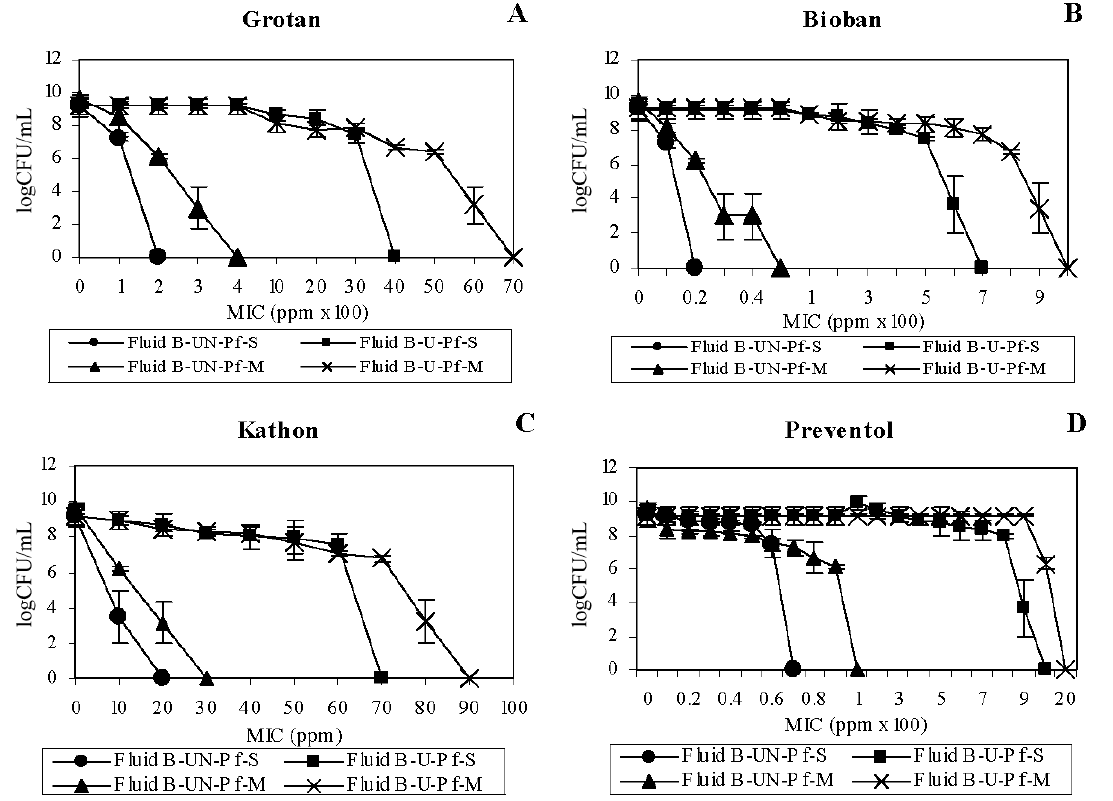
Figure 6. Effect of fluid use on biocidal efficacy toward P. fluorescens . Pristine (unused) and used Fluid B matrices were used to compare the biocidal efficacy of the four test biocides, Grotan (Panel A ), Bioban (Panel B ), Kathon (Panel C ) and Preventol (Panel D ), against P. fluorescens to know the effect of fluid use on biocidal activity. P. fluorescens was exposed to the varying concentrations of each test biocide as single culture (pure) suspension or mixed suspension (1:1 ratio with M. immunogenum ) for 15 min each in the two MWF matrices. Abbreviations: Pf, P. fluorescens ; S, Single culture suspension (pure suspension); M, Mixed culture suspension; UN, Unused; U,